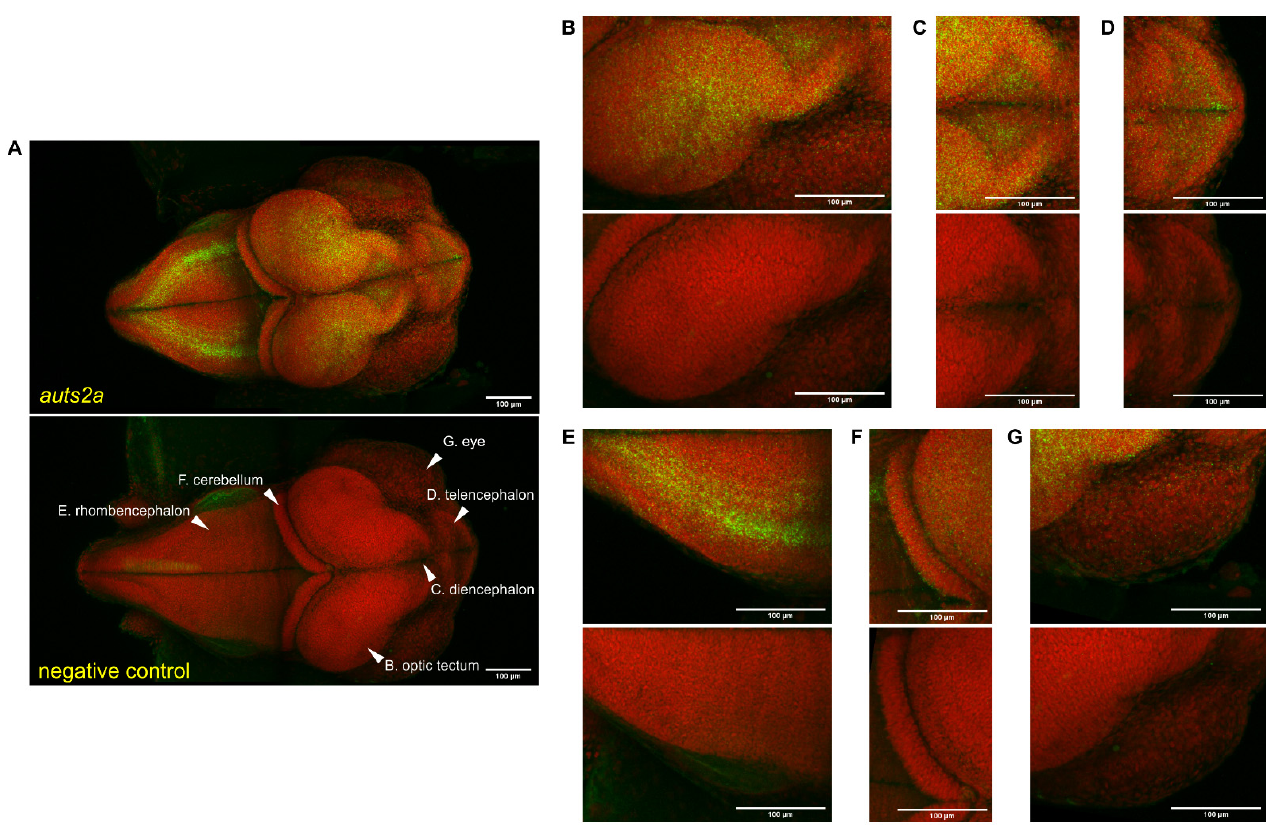
Figure 6. auts2a spatial expression in stage 29 medaka whole embryos using RNAscope. Green staining corresponds to the RNAscope signal. Red staining corresponds to the methyl-green-stained cell nucleus. An RNAscope probe targeting the Bacillus subtilis dapB gene (Accession #: EF191515) was used as a negative control. Images correspond to a maximum intensity Z axis projection for the RNAscope probe and standard deviation Z axis projection for methyl green. ( A ). Whole embryo. ( B ). Optic tectum. ( C ). Diencephalon. ( D ). Telencephalon. ( E ). Rhombencephalon. ( F ). Cerebellum.